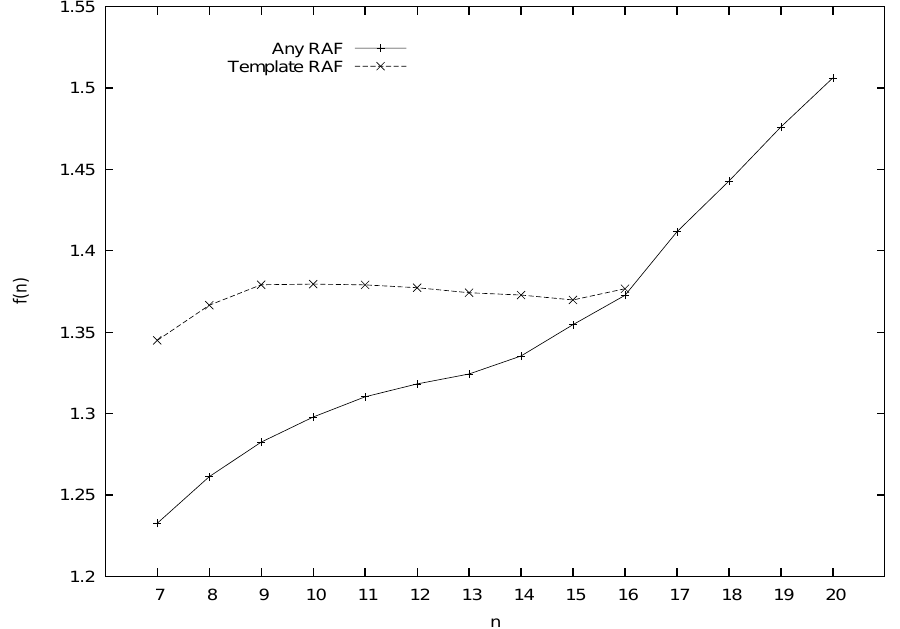
Figure 4. The level of catalysis f ( n ) required for the template-based catalysis case compared to the original (purely random) case, for different values of n